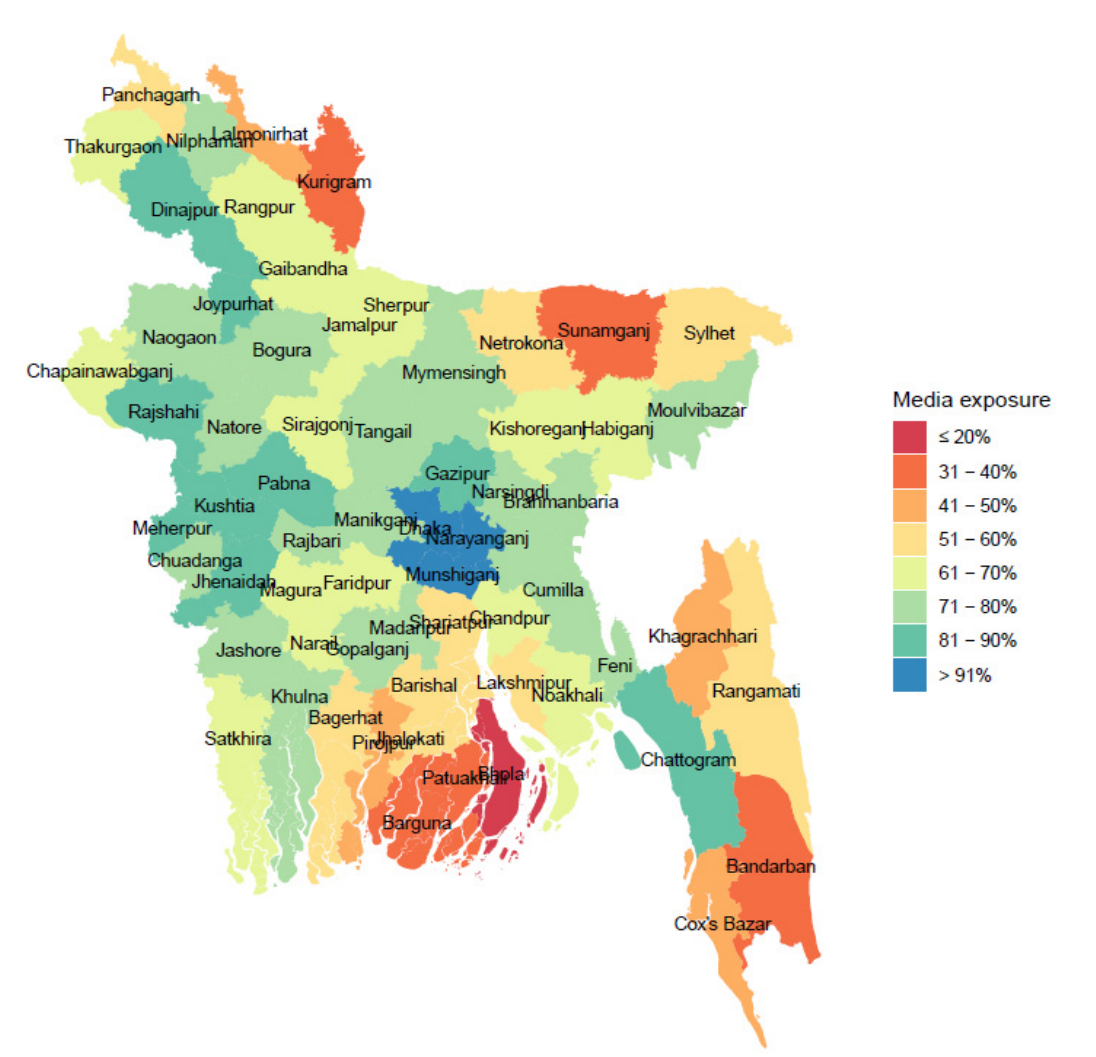
Figure 2. Geospatial distribution of women’s exposure to media among 64 districts in Bangladesh.